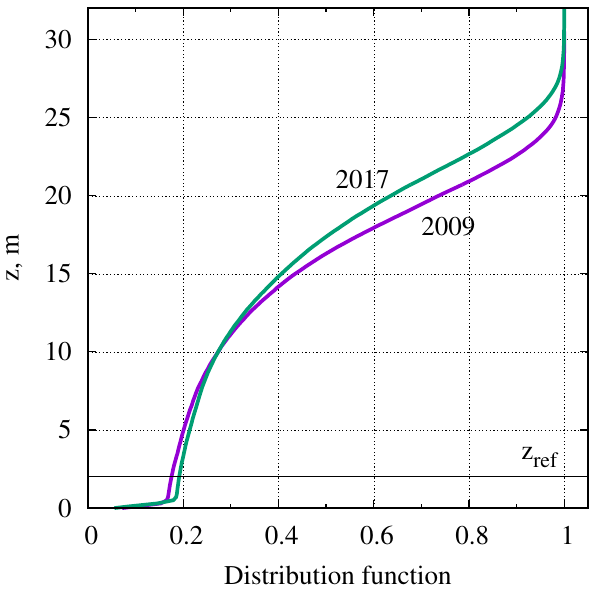
Figure 5. Distribution function of ALS hits in the RAMI spruce stand in 2009 and